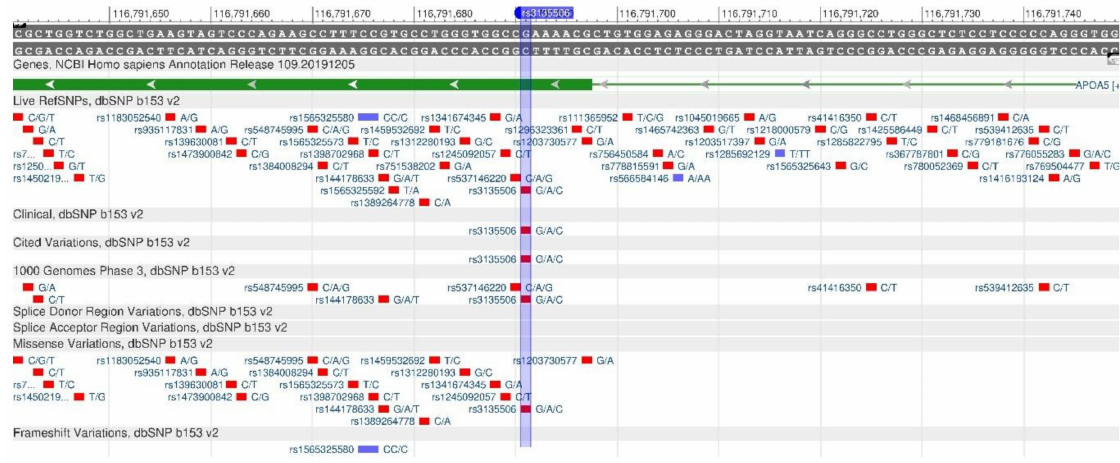
Figure 10. ApoA5 gene region (located on the long (q) arm of chromosome 11) containing the oligonucleotide polymorphism rs3135506.